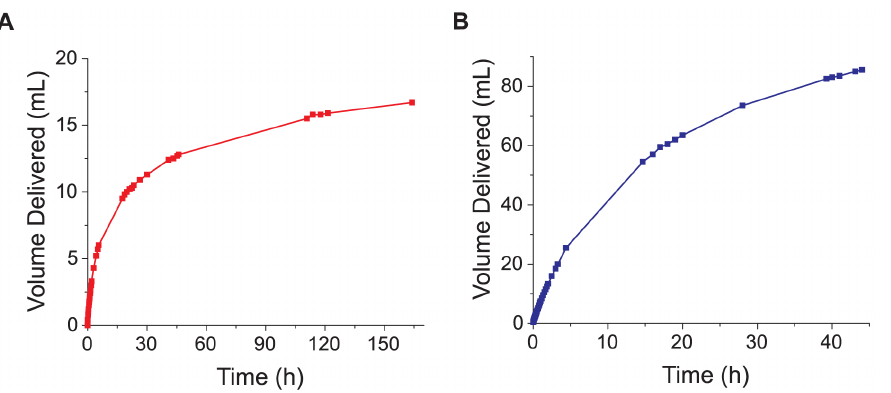
Figure S1 Osmotic pressure as a function of PEG concentration.